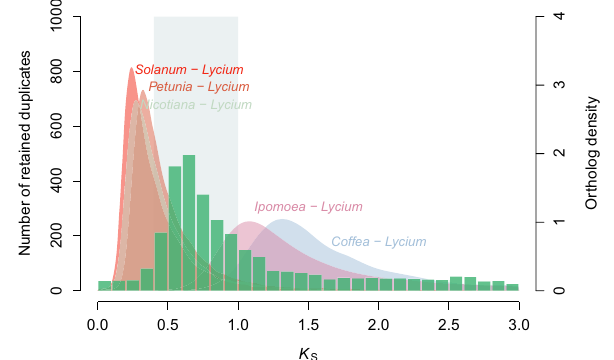
Fig. 2 Whole-genome duplication in Solanaceae. K S age distributions for anchor pairs of L. barbarum (green histogram; left hand y -axis; a peak represents an ancient polyploid event) and for one-to-one orthologues between L. barbarum and S. lycopersicum , N. tabacum , P. axillaris , I. nil , and an outgroup species C. canephora (colored fi lled curves of kernel-density estimates; a peak represents a species divergence event). The gray rectangles highlight the peak found in the anchor pair K S distributions with a range of 0.4 –